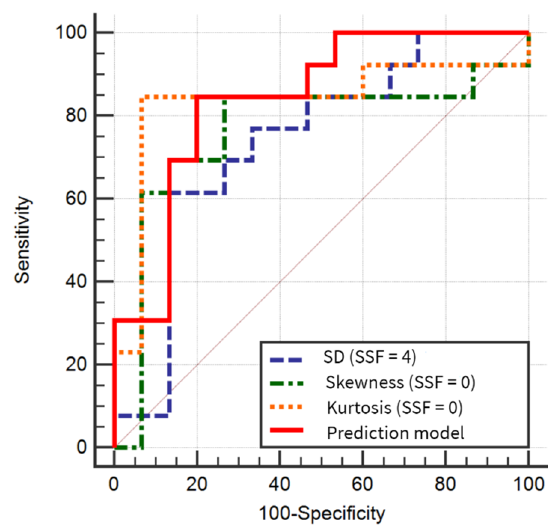
Figure 3. Comparison of areas under the curves for the differentiation of malignant from benign cysts, based on the three texture parameters that showed statistically significant results in the univariate analysis and the prediction model. SSF, the spatial scale of the band-pass filter; SD, standard deviation of pixel intensity.